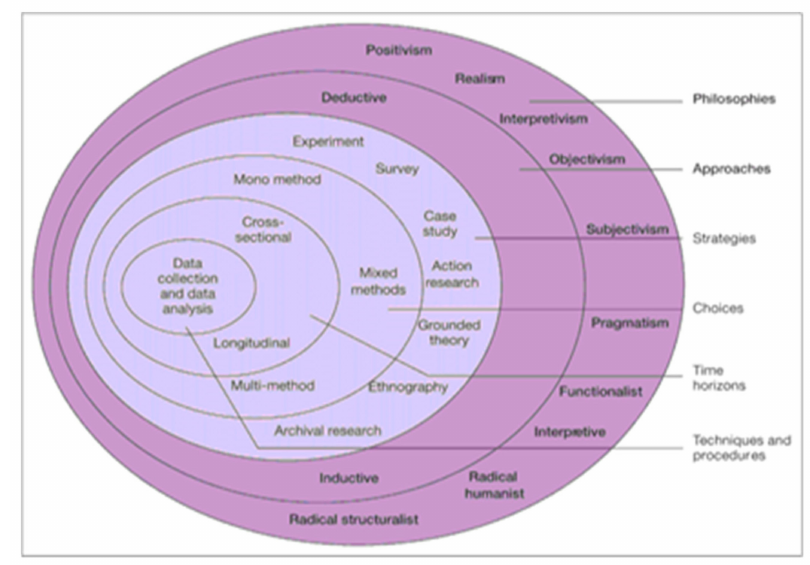
Figure 2. Research onion, after: